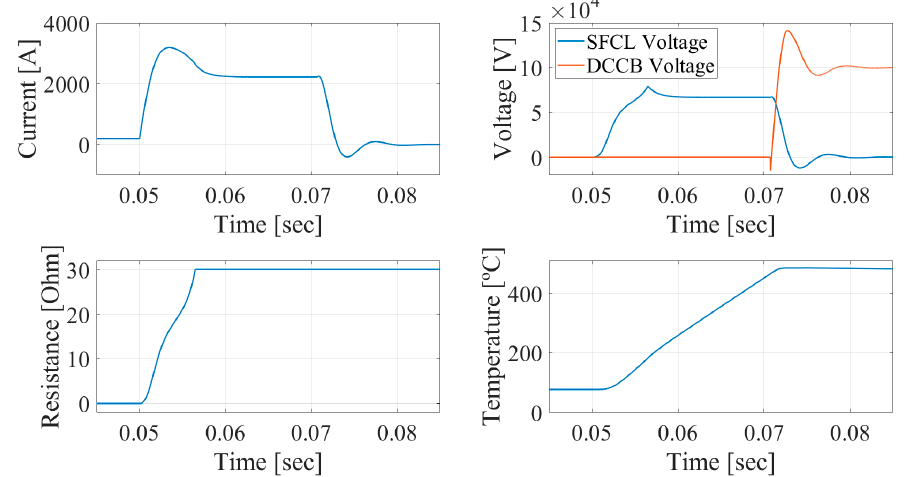
Figure 10. Magneto-thermal model response.